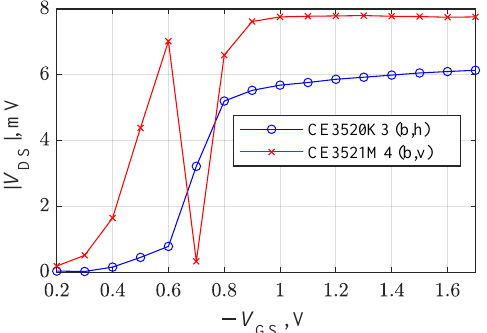
Figure 5. Dependence of the detected drain–source voltage V DS on the gate–source voltage V GS under a 0.307 THz focused